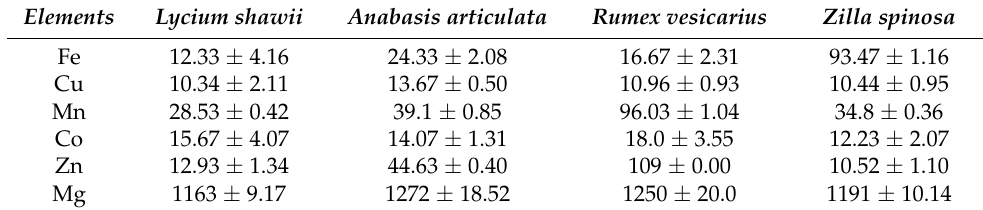
Table 1. Trace elements contents of the four plants ( µ g/kg).